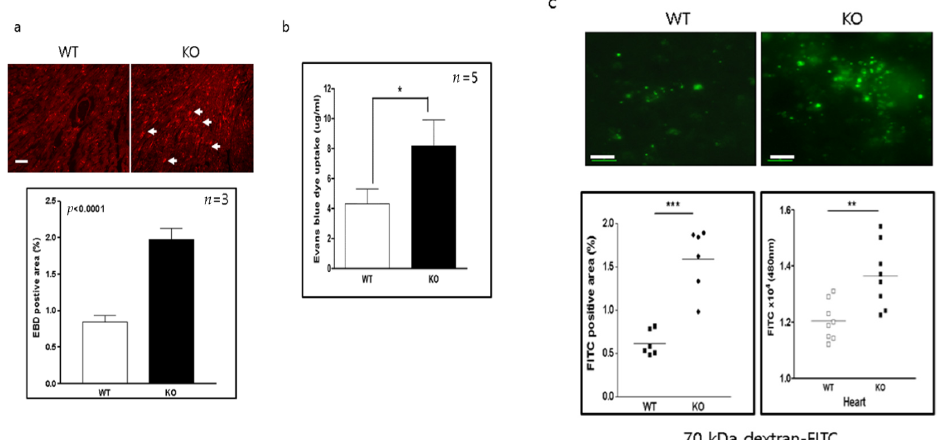
Figure 3. Vascular permeability is increased in the heart of endothelial CAR knockout mice. ( a ). WT and KO mice were injected with 10% Evans blue dye (EBD) for 3 h. Heart was sectioned and subjected to fluorescence microscopy to determine the area of EBD uptake (white arrows; scale bar, 100 µm). ( b ). EBD concentration in the heart extract was measured by microplate reader ( n = 5 per group). ( c ). WT and KO mice were treated with 70 kDa dextran-FITC, and heart sections were examined by fluorescence microscopy to determine the area of FITC uptake (left). Dextran-FITC concentration in the heart extract was measured at 488 nm in a microplate reader (right) ( n = 8 per group; scale bar, 5 µm). All data are the mean ± s.e.m. * p < 0.05, ** p < 0.01, and *** p < 0.001 by two-tailed Student’s t -test.